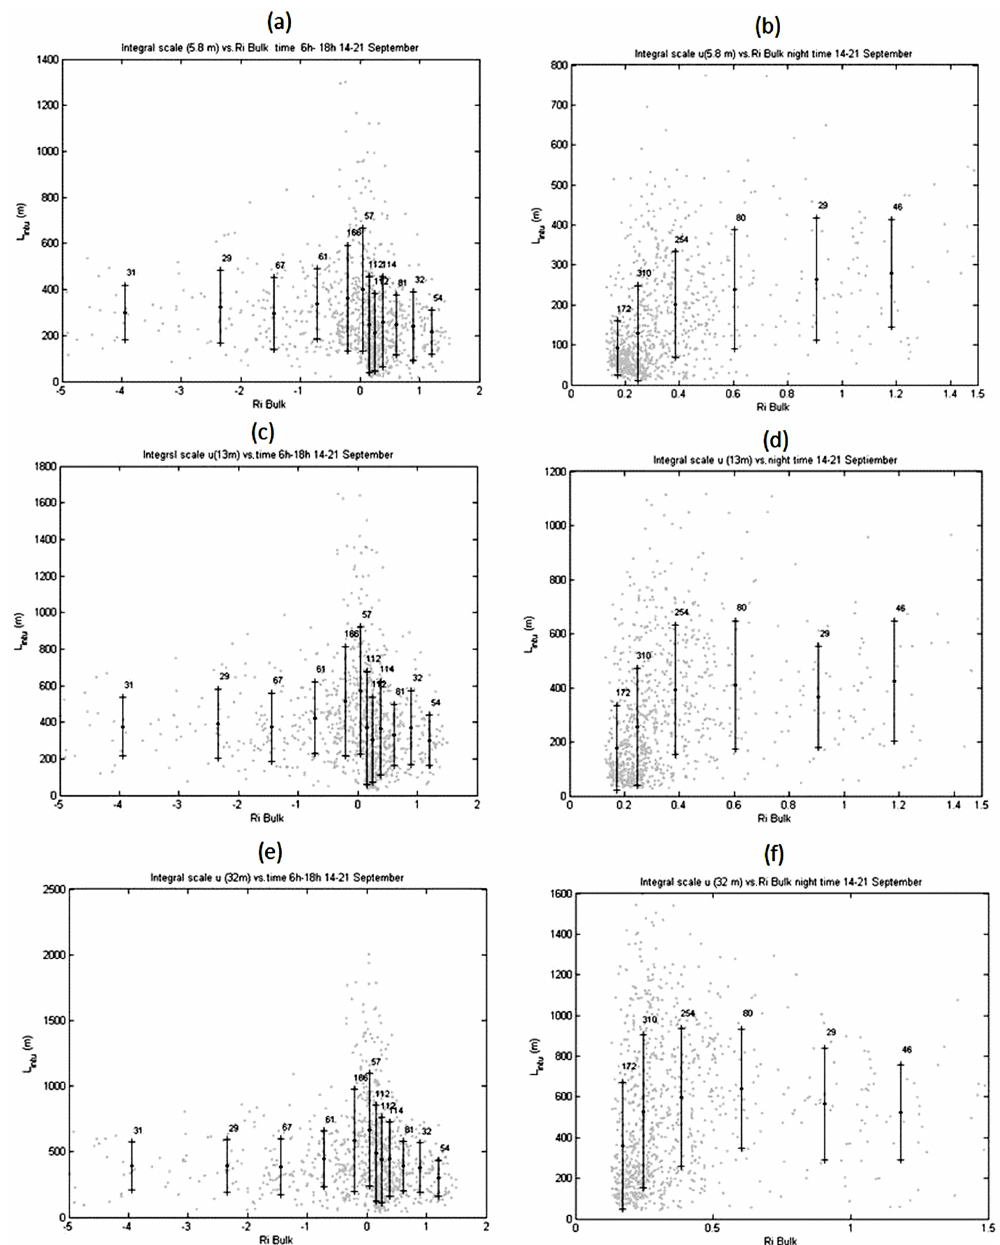
Figure 8. Integral length scales of the u (cid:48) component plotted against the bulk Richardson number at 5.8, 13 and 32m. (a) , (c) and (e) diurnal hours; (b) , (d) and (f) night